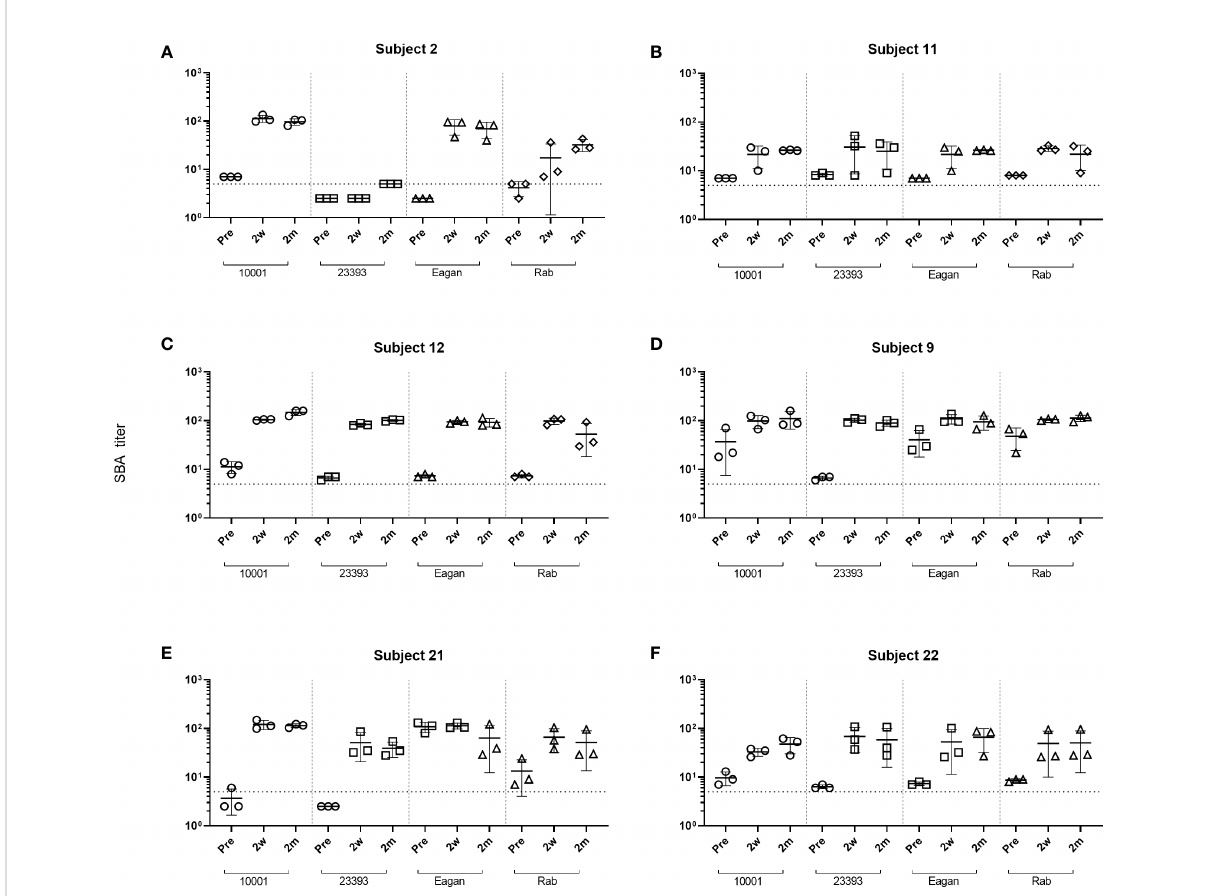
FIGURE 2 Changes in SBA titers against Hib isolates after ActHIB vaccination. SBA titers of sera taken prior to vaccination (Pre), 2 weeks (2w) and 2 months (2m) post-vaccination from six volunteers (A – F) . SBA titers are the reciprocal dilutions of serum that result in 50% killing of the bacteria after 60 minutes incubation. The lowest serum dilution measured was 1:5. Error bars represent the standard deviation of the mean titer of triplicate technical replicates. The bottom dotted line indicates a SBA titer of 5. For serum/isolate combinations that had a SBA titer <5, symbols were set below that line to a SBA titer of 2.5, indicating titers below detection